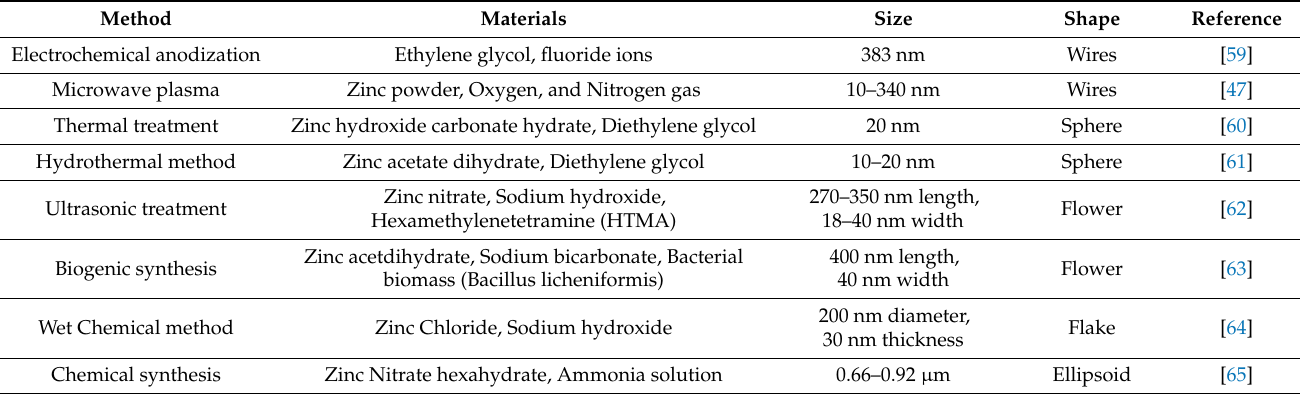
Figure 11. FE-SEM micrographs of ZnO nanostructures at applying voltages of ( a , b ) 40 V, ( c , d ) 30 V, and ( e , f ) 20 V. Reprinted with permission from [59]. Copyright (2021) Elsevier B.V. Table 1. Synthesis of ZnO nanoparticles via traditional